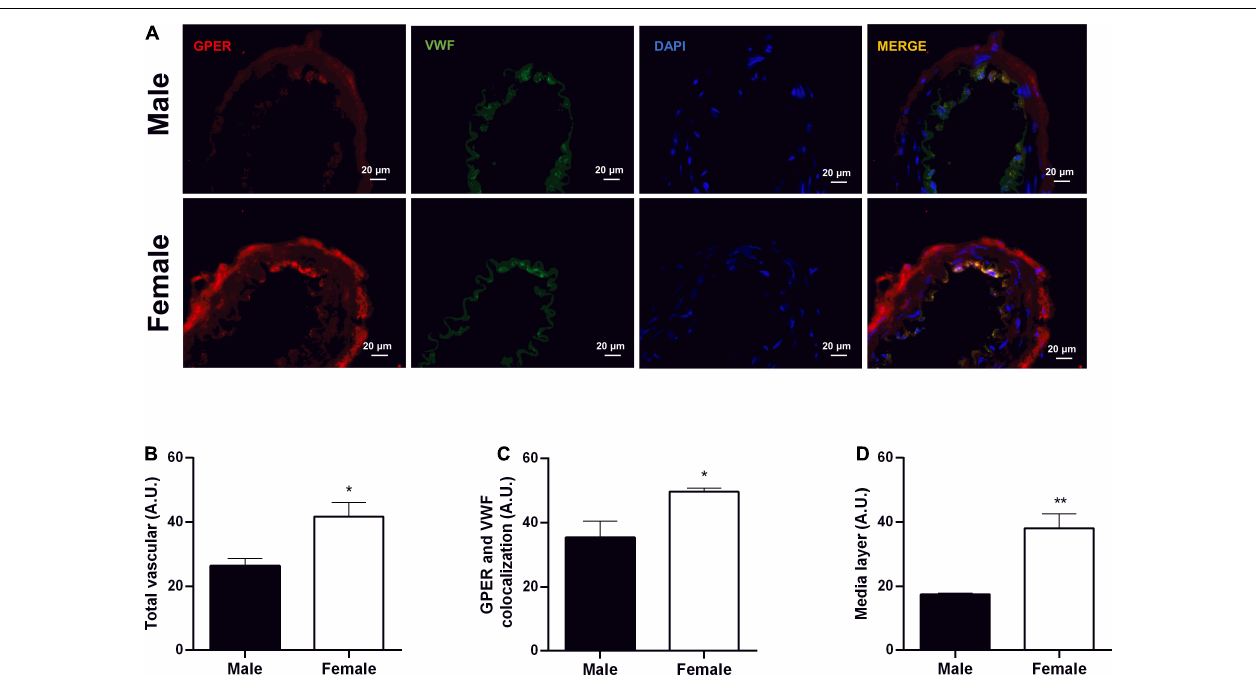
FIGURE 9 | Greater fluorescence intensity of GPER in mesenteric resistance arteries of female SHR. Immunolocalization for GPER (A) and fluorescence analysis of total vascular area (B) , endothelium area (C) , and vascular smooth muscle area (D) in Male ( n = 5) and Female ( n = 4) SHR groups. Scale bar = 20 µ m. Values are expressed as mean ± SEM. ∗ P < 0.05 and ∗∗ P < 0.01 compared with Male SHR group. Mann-Whitney test was used for the